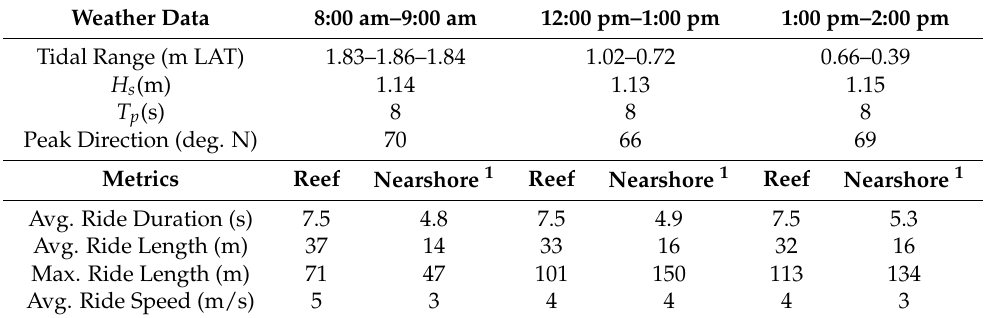
Table 3. Summary of WPT data over each